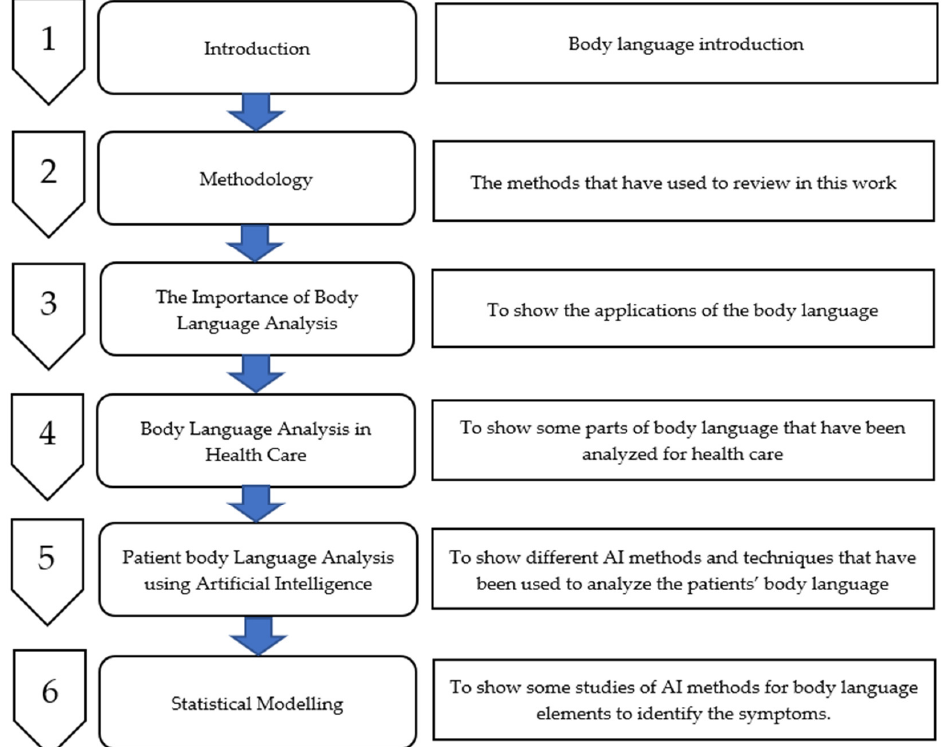
Figure 1. The Review